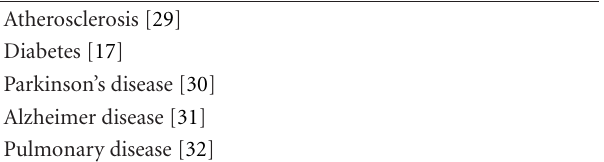
Table 1: Diseases in which ferritin levels increase or decrease. Table 2: Ferritin implicated in the pathogenesis of the following